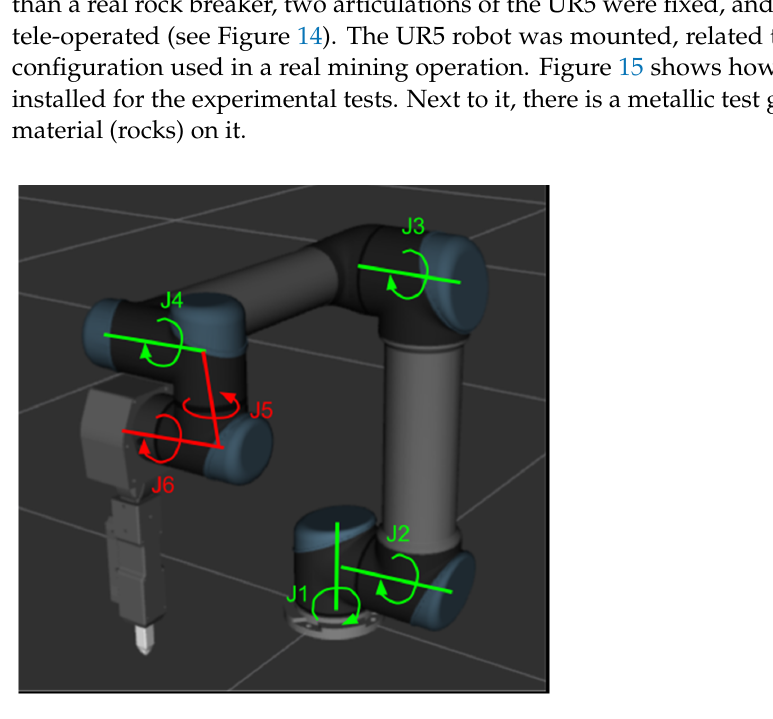
Figure 15. Experimental operation of the rock breaker set-up. Two mounting-bases, each one containing a camera and a 3D LIDAR, are placed around the operation environment. This allows for the sensors to be located above the operational set-up, pointing to the grizzly and covering it completely (see Figure 16). In this work, Livox model MID-40 3D LIDARS and Arecont model AV5225 PMIR visible spectrum cameras are used.